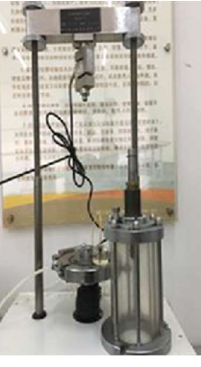
Figure 4. Strain-controlled triaxial apparatus.